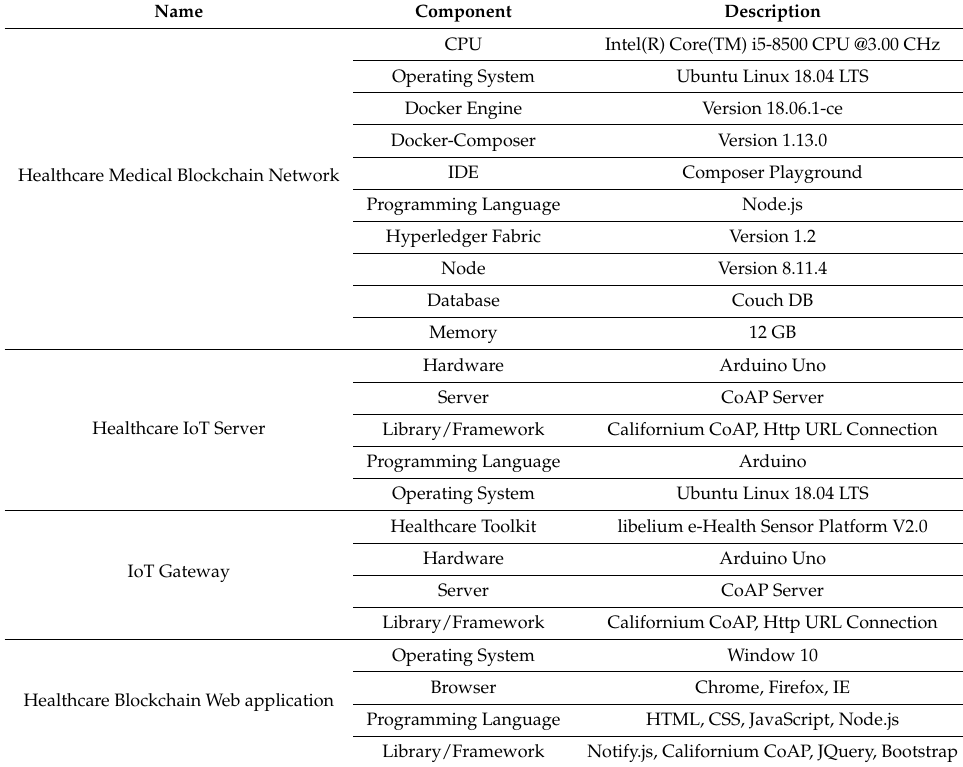
Table 3. Development environment for the proposed patient vital-sign